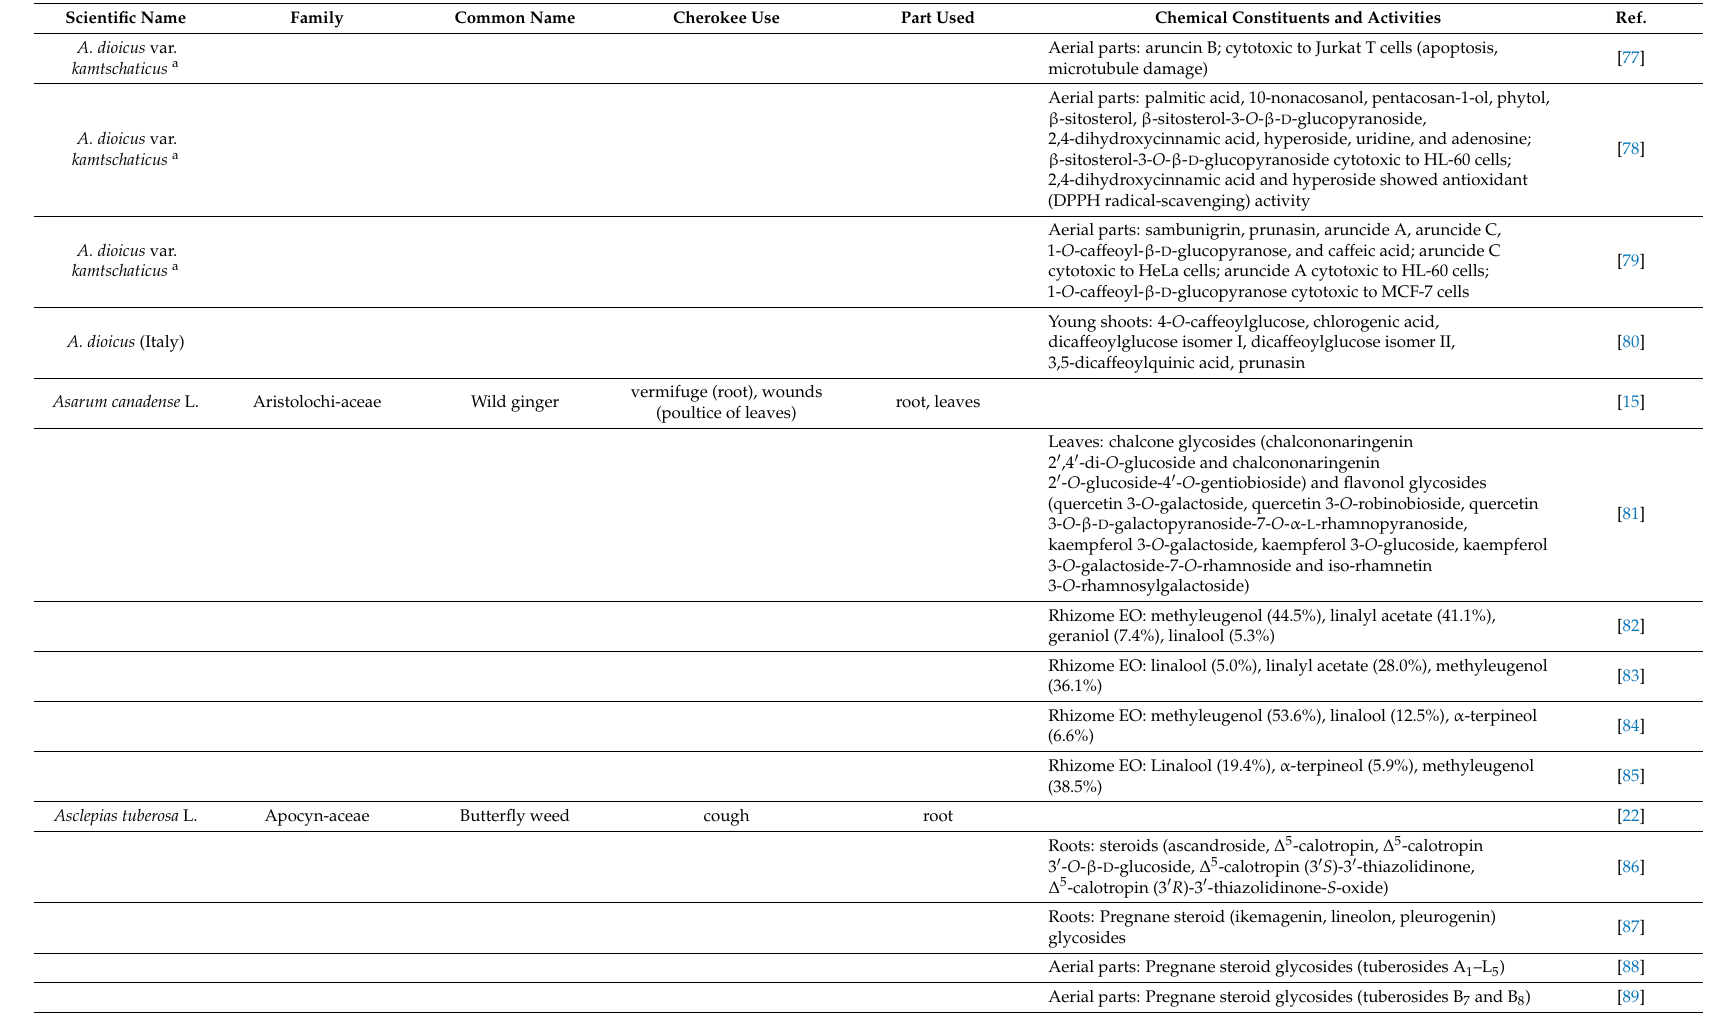
Aerial parts: Pregnane steroid glycosides (tuberosides A 1 –L 5 ) Aerial parts: Pregnane steroid glycosides (tuberosides B 7 and B 8